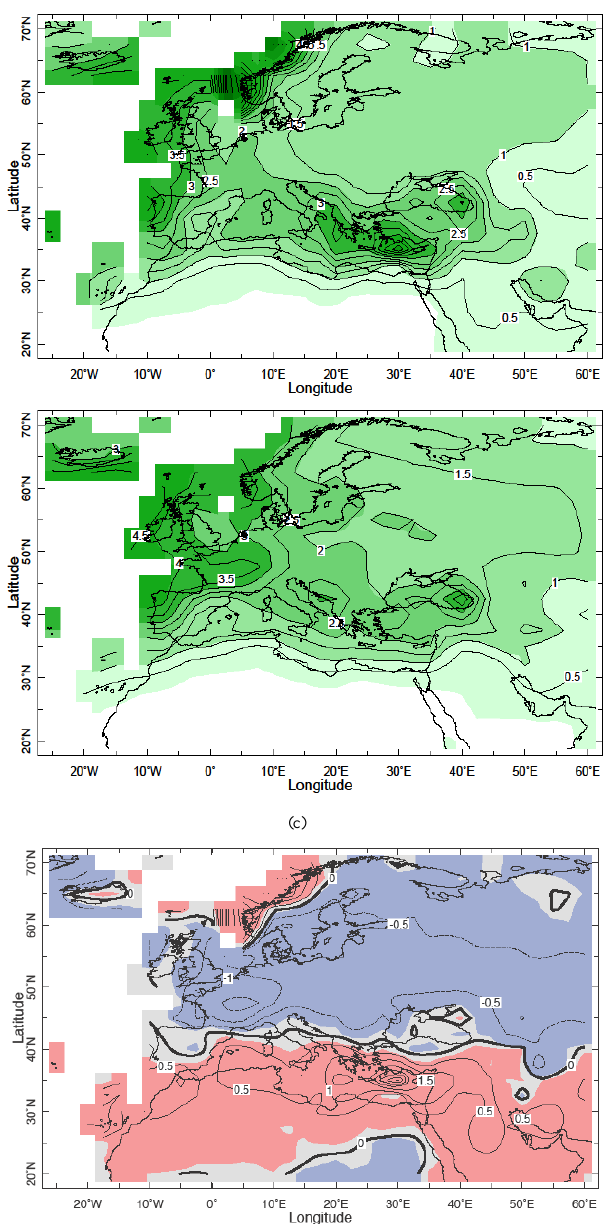
Fig. 10. Long-term mean of the DJF precipitation according to ob- servation (a) , taken from the NOAA/NCEP CAMS data set (Ro- pelewski et al., 1984, Janowiak and Xie, 1999), the 9 study models (b) and difference between them (c) , in mmday − 1 units. The reso- lution of the observed precipitation is 2 ◦ × 2 ◦ . The sign and signifi- cance of the trend is represented as in Fig.